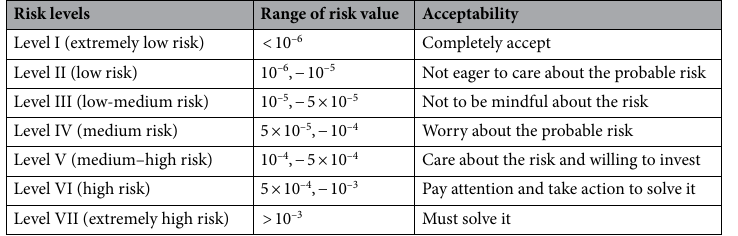
Table 2. Levels and values of assessment standards 36,37